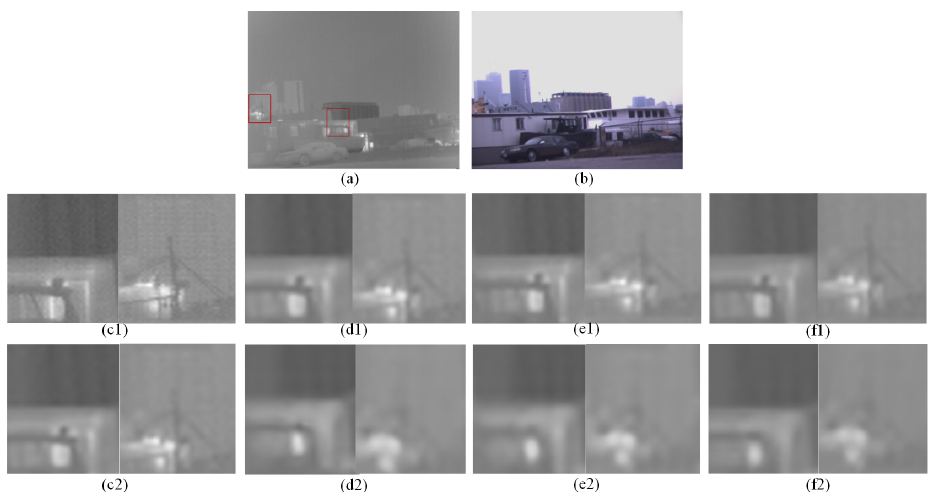
Figure 11. The visual quality comparison for an image from OutdoorUrban datasets with scale ˆ 2 and ˆ 4.( a ) is infrared image as input ( b ) is the RGB image as input. ( c1 – f1 ) is SR results for ˆ 2 scale respectively proposed method, vdsr, srcnn, A+. ( c2 – f2 ) is SR results for ˆ 4 scale respectively proposed method, vdsr, srcnn, A+.